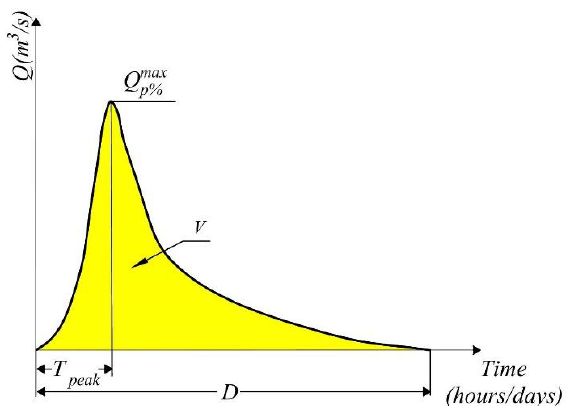
Figure 1. Parameters of the analytic skewed flood hydrograph.